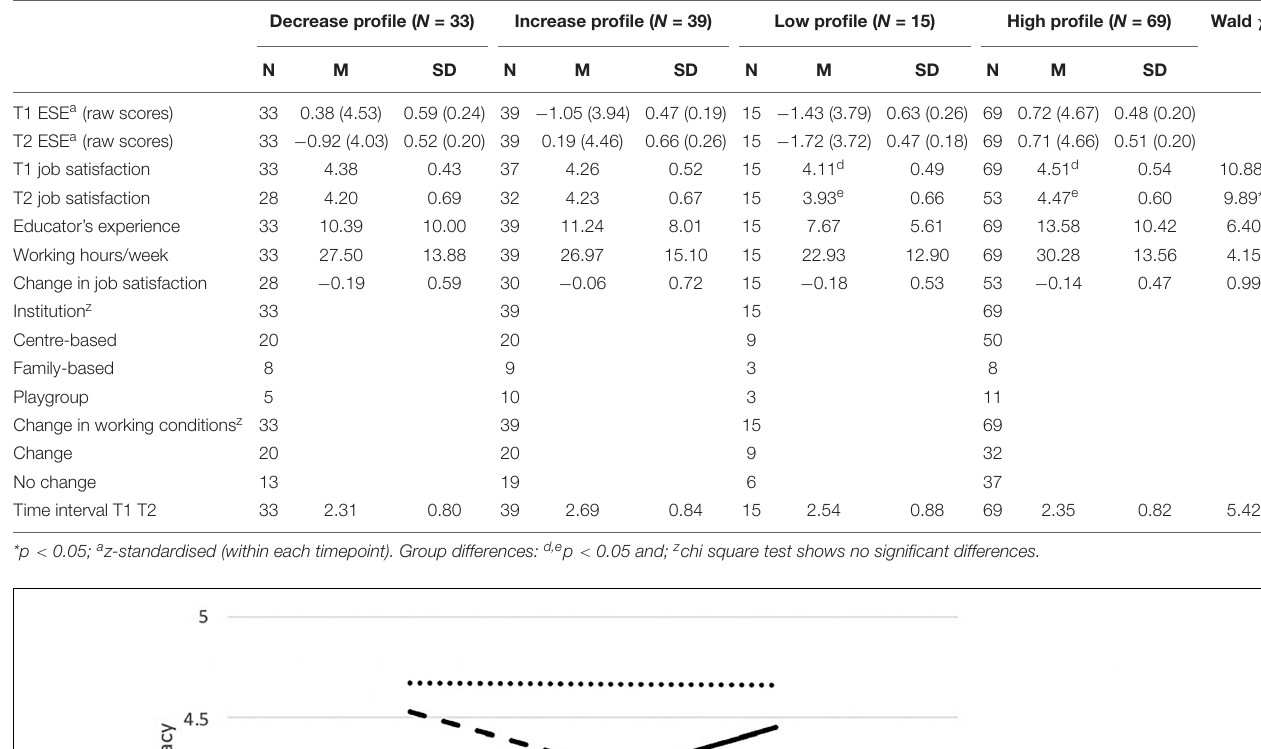
TABLE 1 | Results of latent profile and univariate analyses ( N = 128–156).